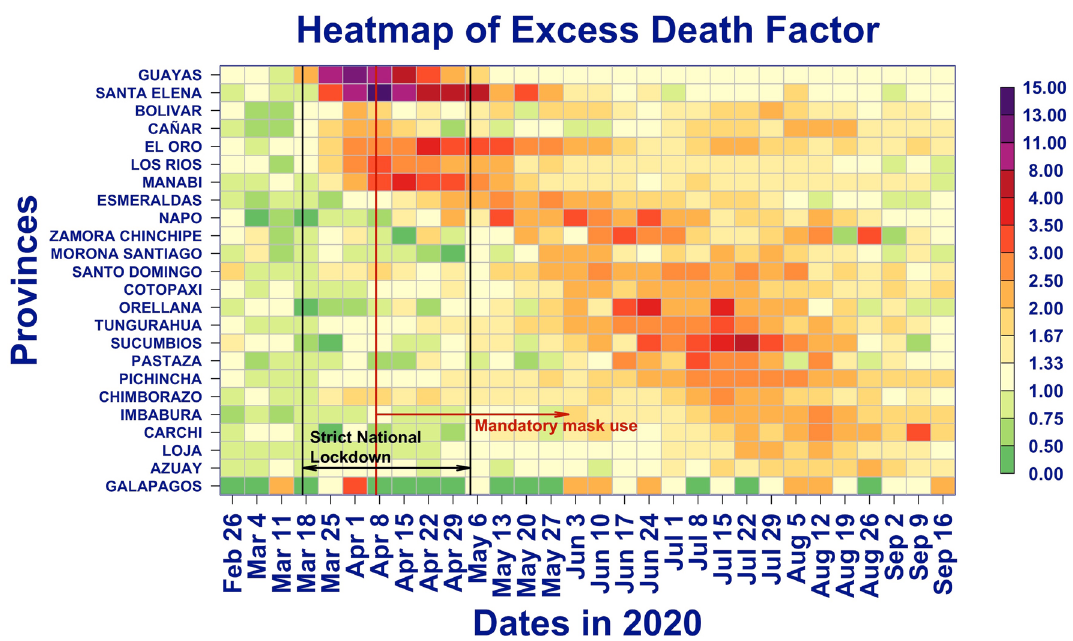
Figure 5. Heatmap of excess death factor by province with national